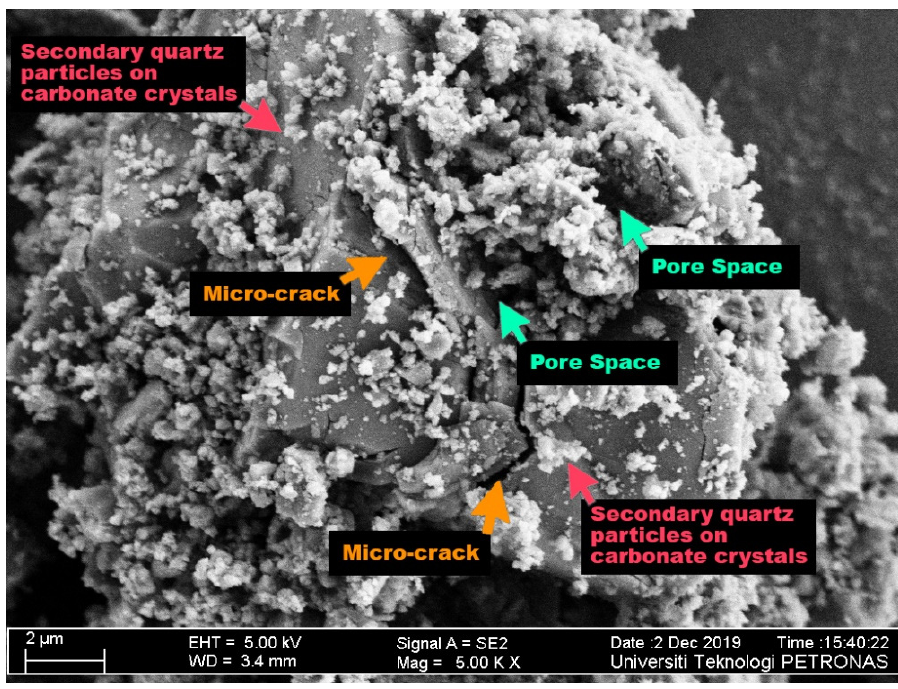
Figure 6. FESEM image of sample A-1.1 before permeability measurement.